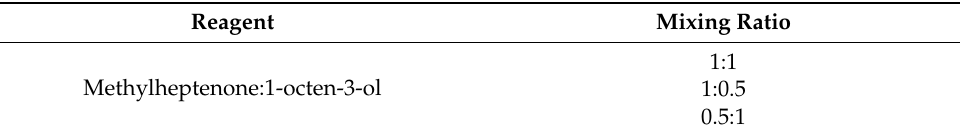
Table 3. The proportion of the